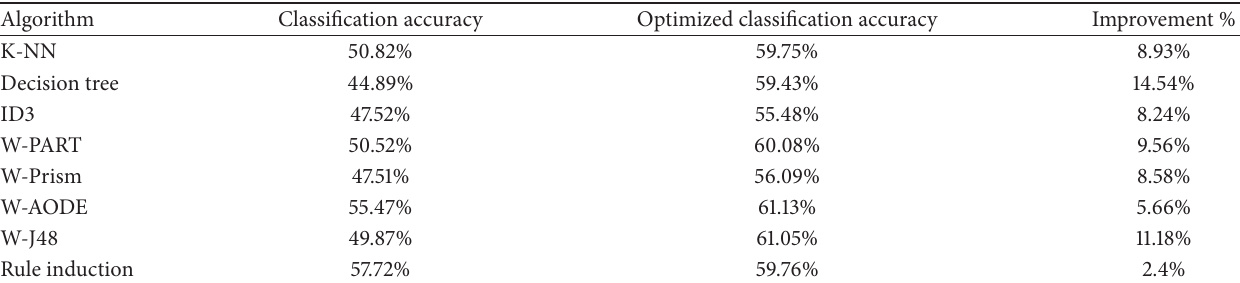
Table 7: Results for heart disease dataset: comparison of optimized classification accuracy using GMC model with simple classification using different